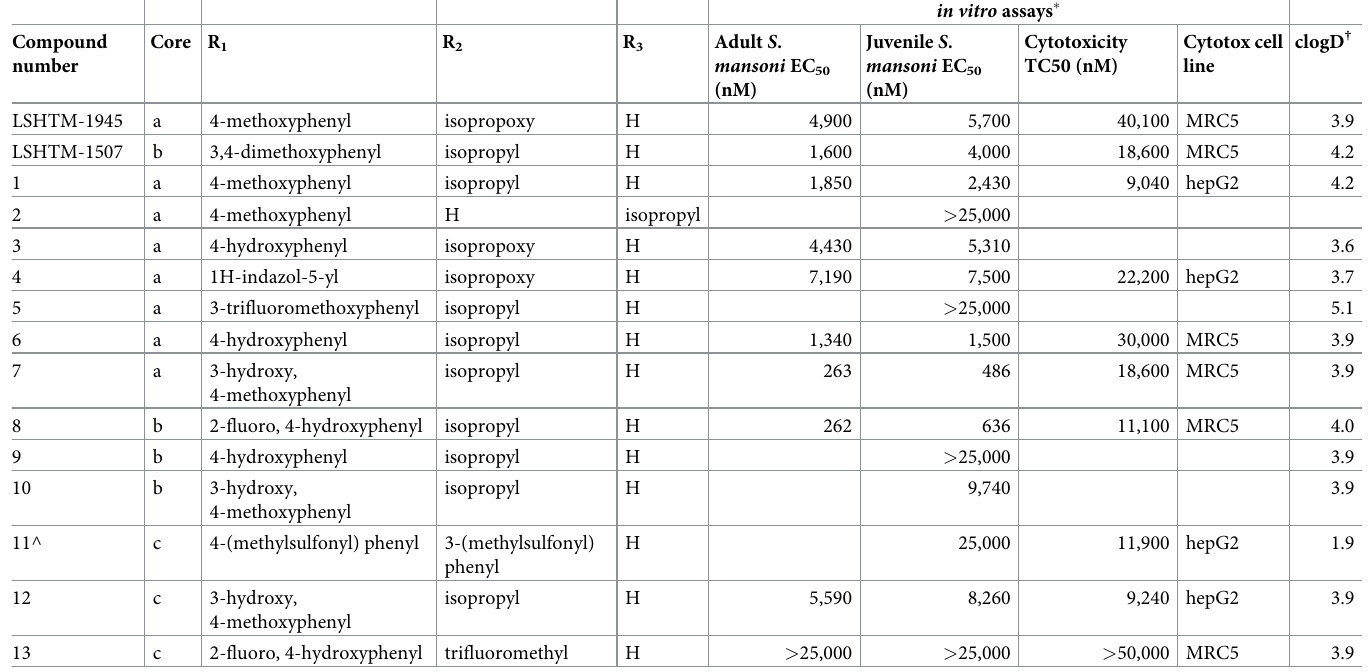
Table 1. Structure and activity of hits and early analogues.